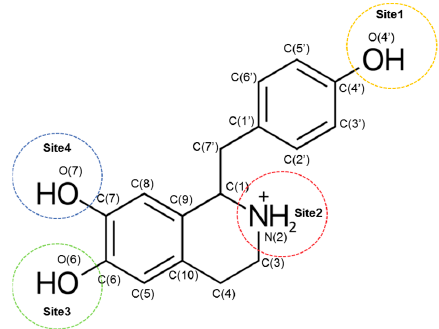
Figure 1. The 2D structure of higenamine.